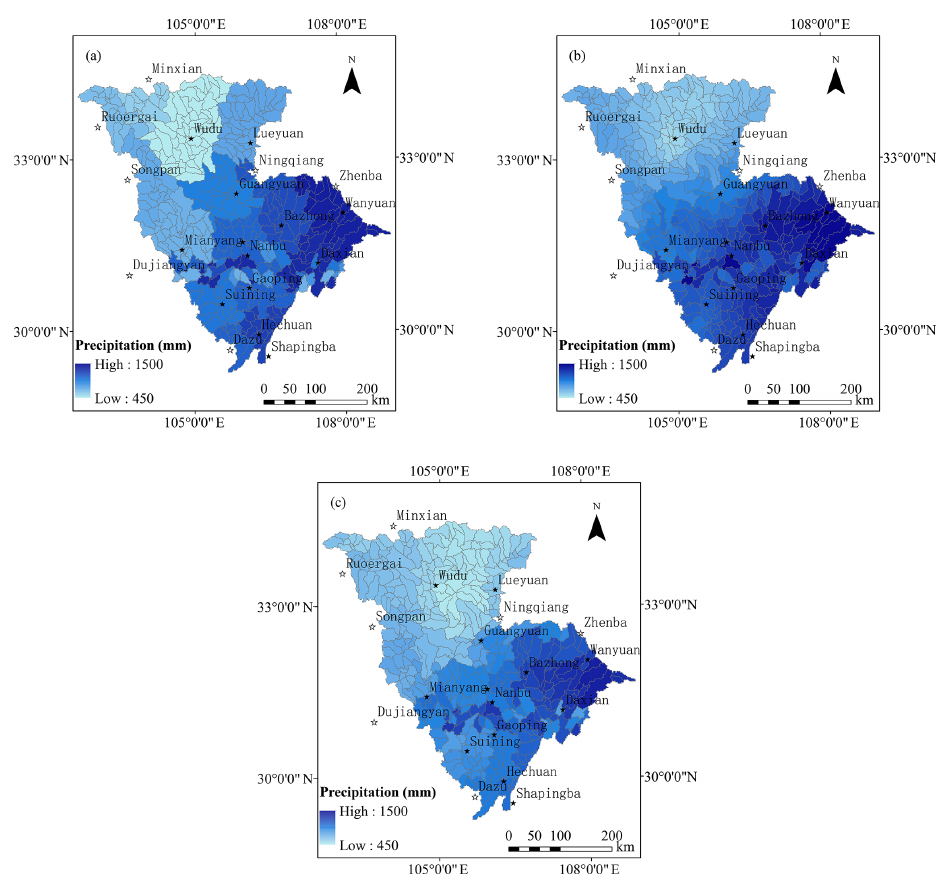
Figure 7. Spatial variation of annual precipitation at a subbasin scale for (a) Gauge, (b) CHIRPS, and (c)